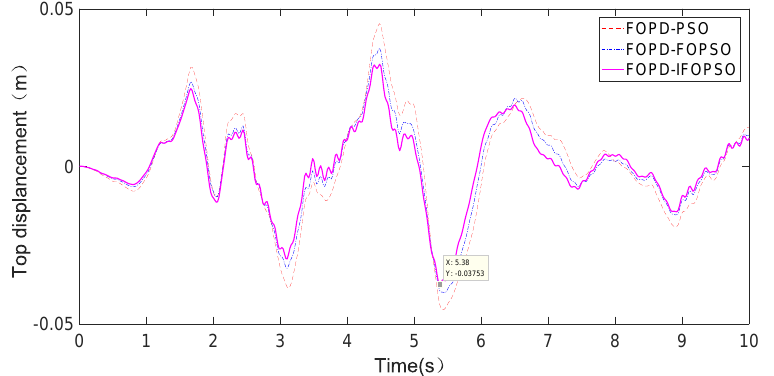
Figure 5. Top displacement versus time for the three algorithms under earthquake seismic wave excitation.